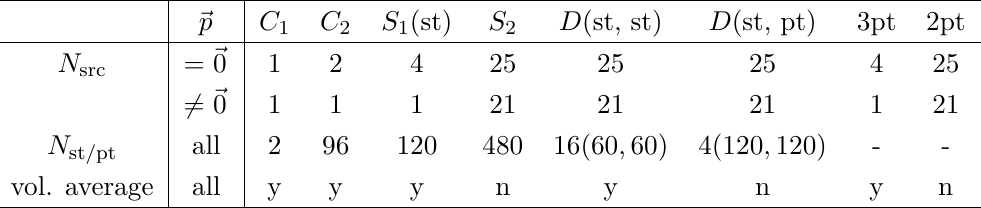
Table 4 . Overview of the statistics of our simulation for each Wick contraction. If the contractions involve the loop L , we indicate by (st) or (pt) which version is employed. N refers to the 1 src number of proton sources for which each graph is evaluated. N is the number of stochastic st / pt sources used for the calculation of the stochastic propagators. For the graphs involving loops where multiple point sources are used ( S and D (st, pt)), N refers to the corresponding number of 2 st / pt point sources. In the last line we indicate whether volume averaging is